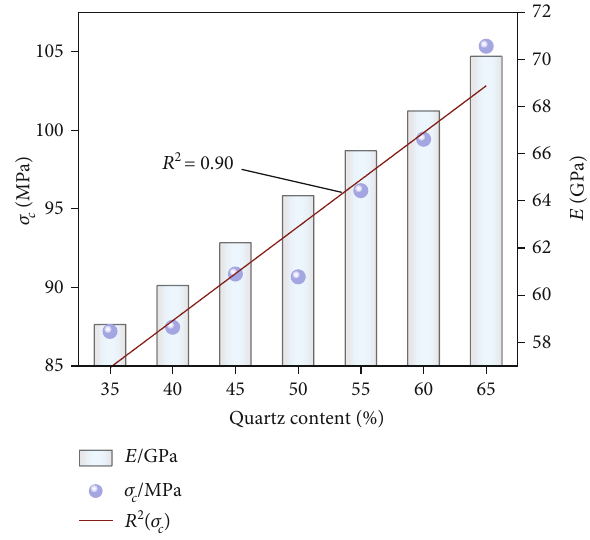
Figure 13: Variation trend of the compressive strength and elastic modulus of shale with di ff erent quartz contents.